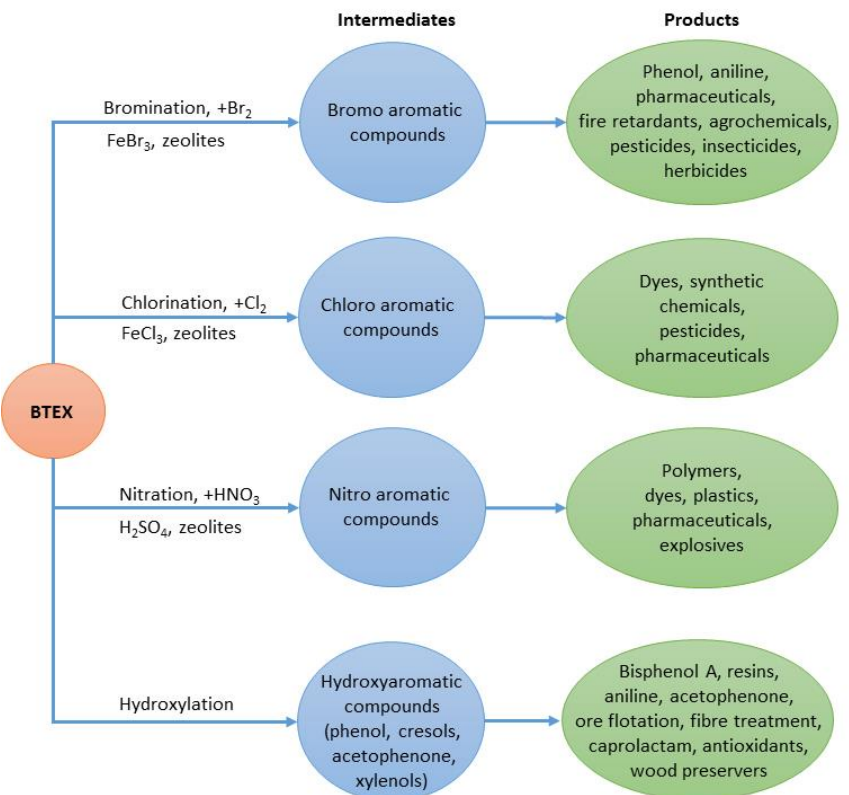
Figure 3. Products and intermediates from BTEX (benzene, toluene, ethylbenzene and xylenes) compounds